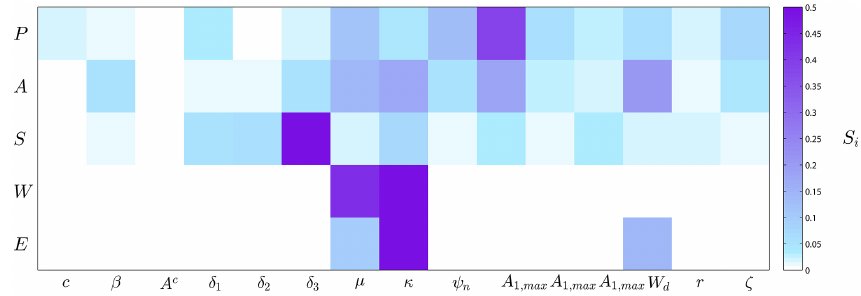
Figure 13. Sensitivity index Si for all parameters, indicating the sensitivity of population N , irrigated area A , storage S , wetland storage W and environmental awareness E to the parameter